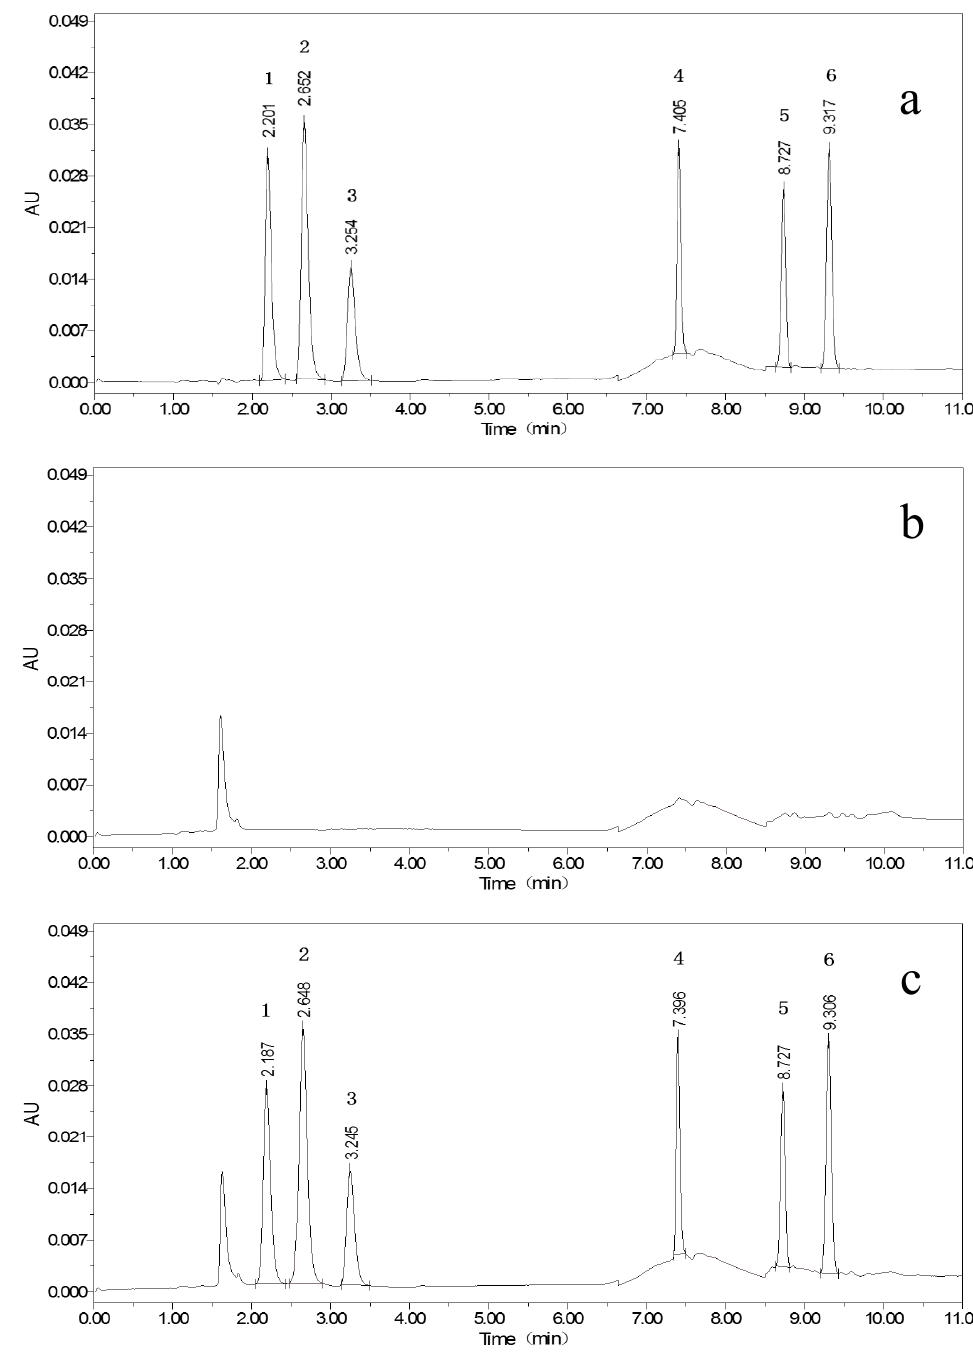
Figure 1. Chromatograms of 100 µg/kg mixed standards ( a ); blank whole egg ( b ); and blank whole egg with 100 µg/kg mixed standards ( c ) (ABZSO 2 NH 2 (1), ABZSO (2), ABZSO 2 (3), ABZ (4), AVM (5), IVM (6)).